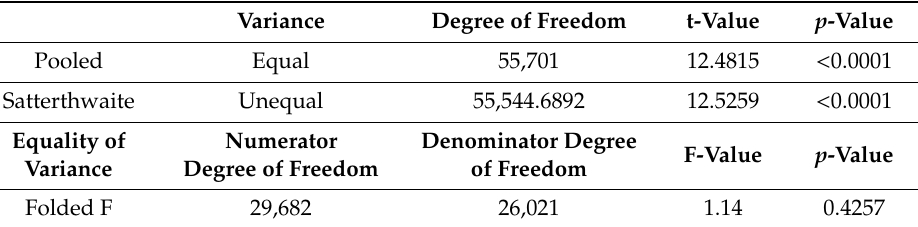
Table 13. Two-sample t -test for